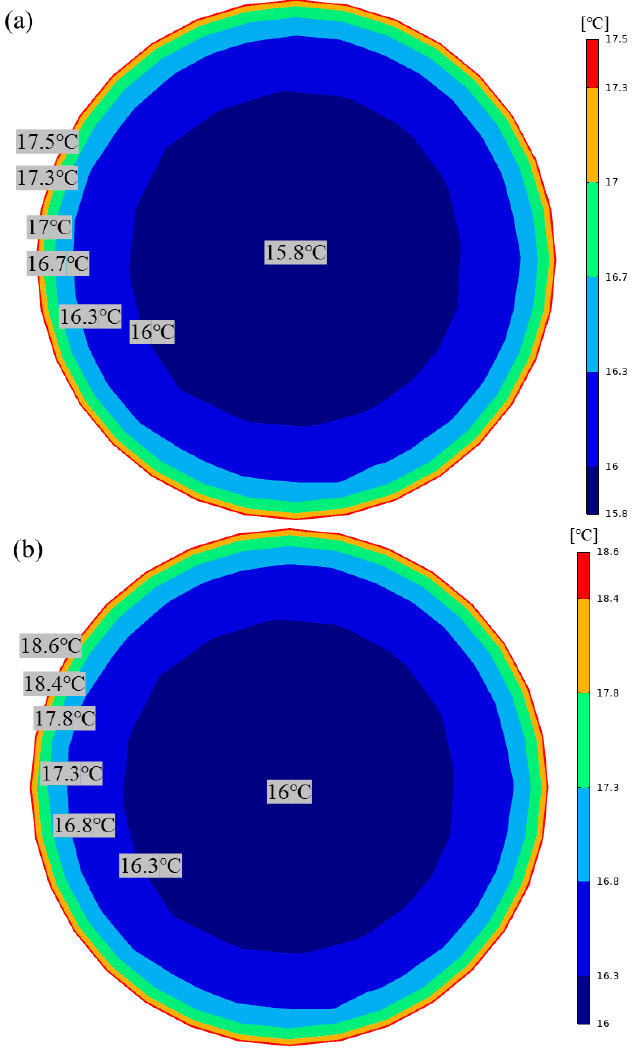
Figure 16. Temperature field of air flow at the exit of the roadway: ( a ) Temperature field cloud of plain mortar supported tunnel. ( b ) Temperature field cloud of insulated mortar supported tunnel.